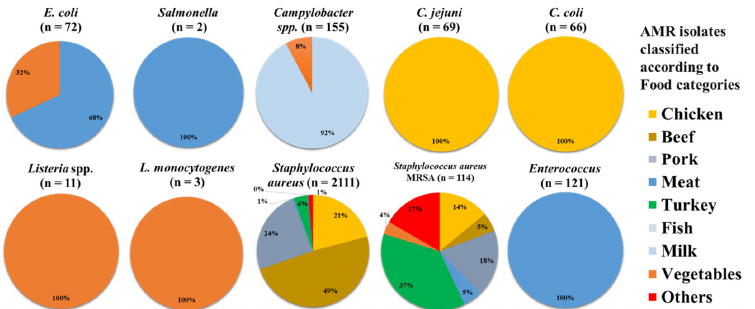
Figure 4. Distribution of the number of food samples in the USA (n = 2724) that had AMR isolates in them, broken down by food types. In each pie chart, the total at the top indicates the (n) number of samples used to produce the graph.